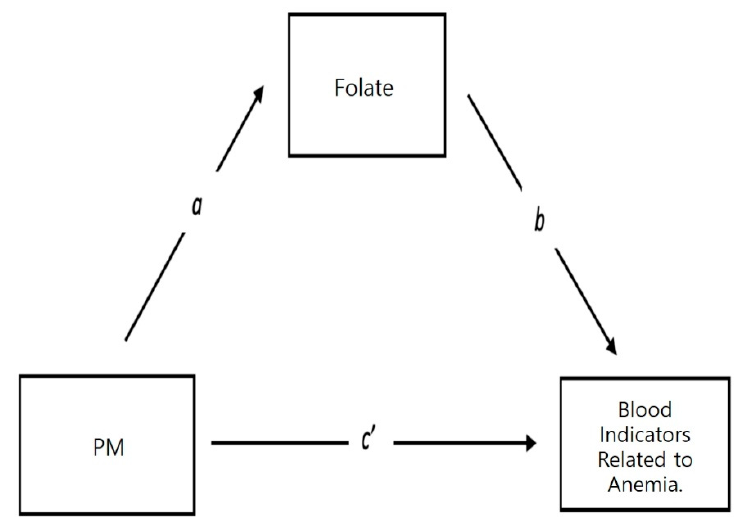
Figure 3. Direct and indirect effects of particulate matter and blood indicators related to anemia. Table 4. Mediation analysis of baseline study particulate matter (gravimetric PM10) exposure for blood indicators related to anemia.